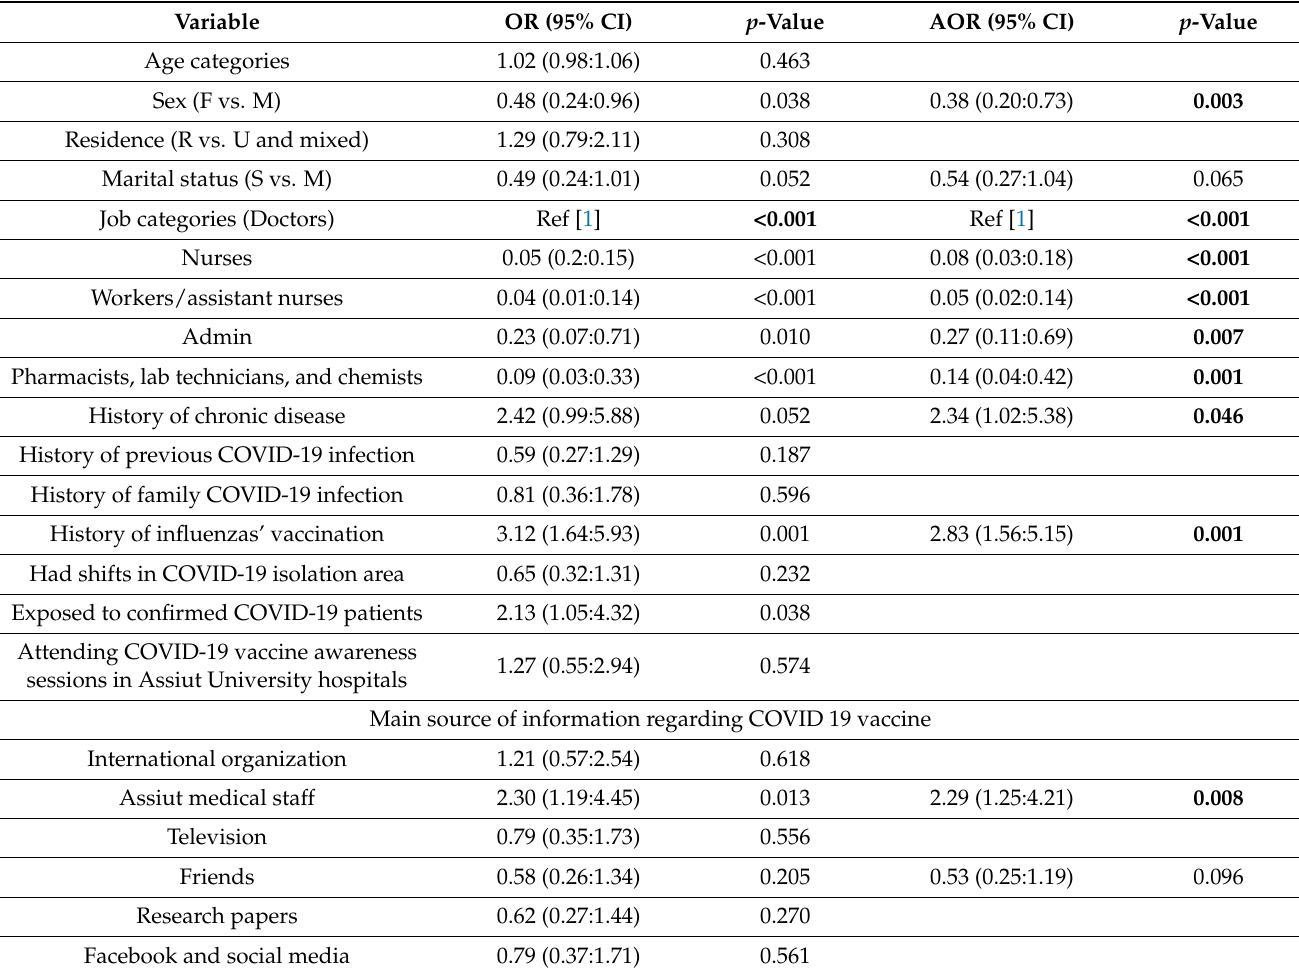
Table 4. Multivariable regression analysis for the main predictors for accepting the COVID-19 vaccine among offered cohort